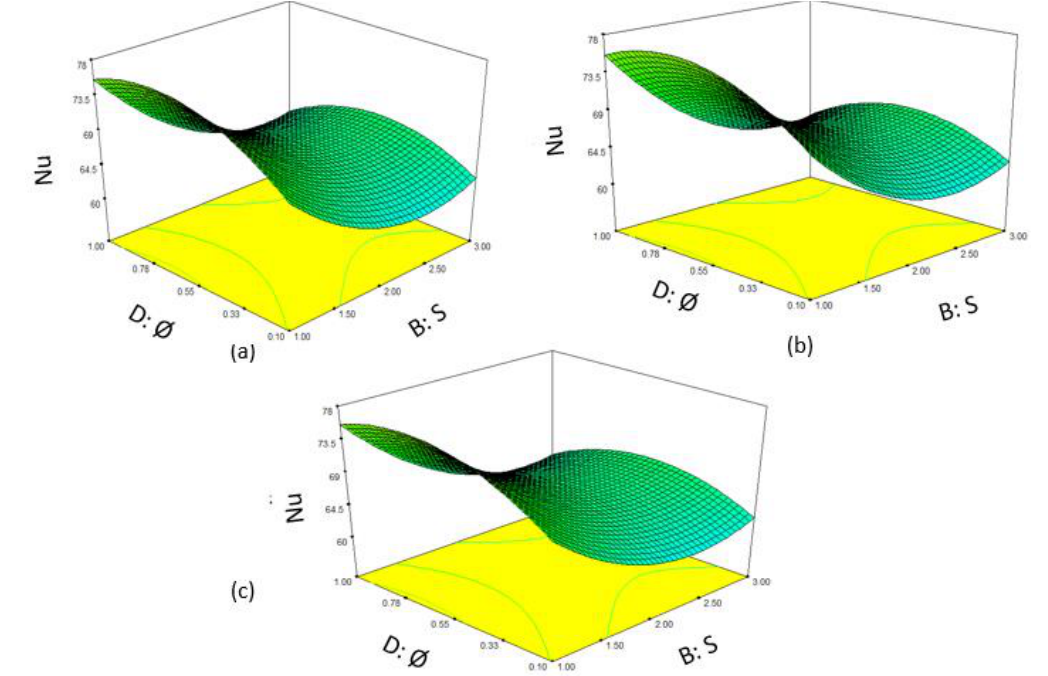
Figure 12. Nusselt number contours and 3D surface formed by the effect of the nozzle-nozzle spacing and phase angle at the optimum conditions for the optimization target of maximum Nusselt number and nanoconcentration equal to ( a ) 0.1%; ( b ) 0.5%; ( c ) 1%.